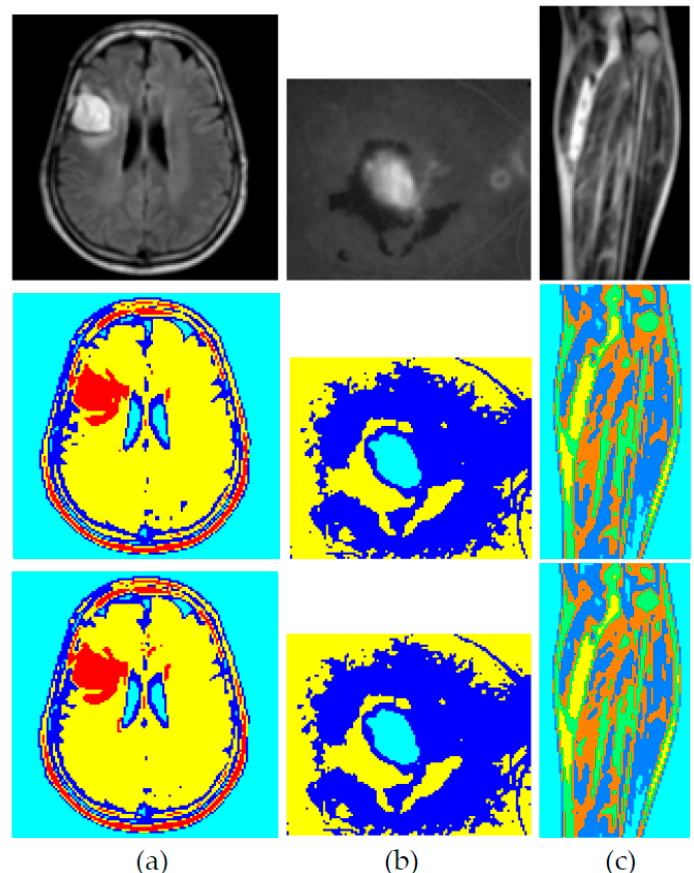
Figure 11. Top to bottom: original image, segmentation result of proposed model of PAM algorithm, result of K-Medoids clustering by [17]: ( a ) MRI scan of a brain to detect tumor (T2W image with full brain coverage in axial plane), SSIM = 0.97; ( b ) Fluorescein angiography of a retina to detect neovascular AMD, SSIM = 1.00; ( c ) MRI scan of a leg to detect fluid collection in calf muscles due to injury (T2W image in coronal plane), SSIM = 0.93.